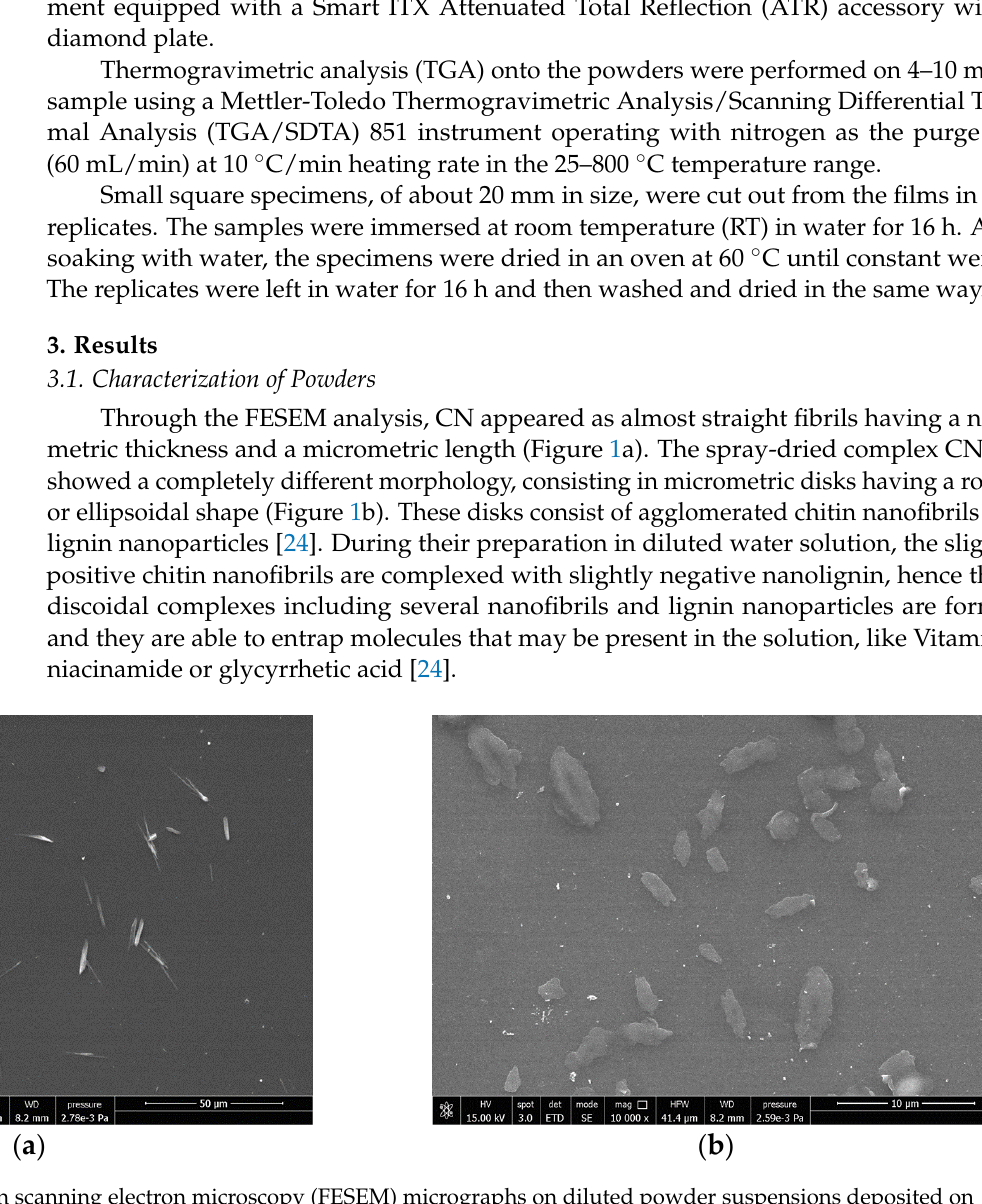
Figure 1. Field emission scanning electron microscopy (FESEM) micrographs on diluted powder suspensions deposited on glass: ( a ) chitin nanofibrils (CNs), ( b ) chitin nanofibrils–nanolignin complex